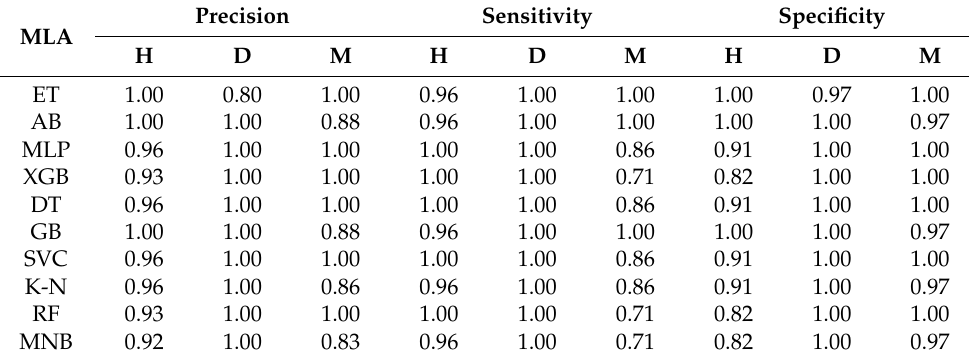
Table 3. Validation metrics to determine the performance of the machine learning models. Precision Sensitivity Specificity MLA